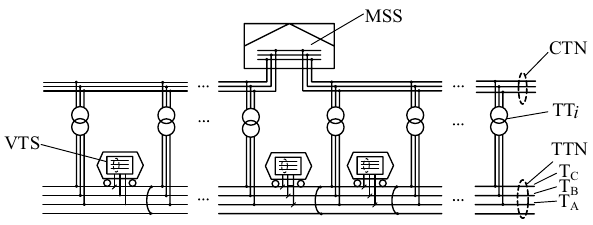
Fig. 1 Three-phase traction power supply